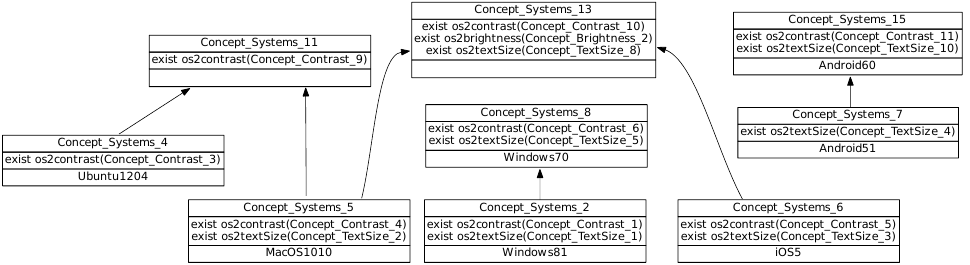
Figure 13. Excerpt of the central concept lattice (redrawn from the output of the tool for the sake of explainability) to illustrate relationships between